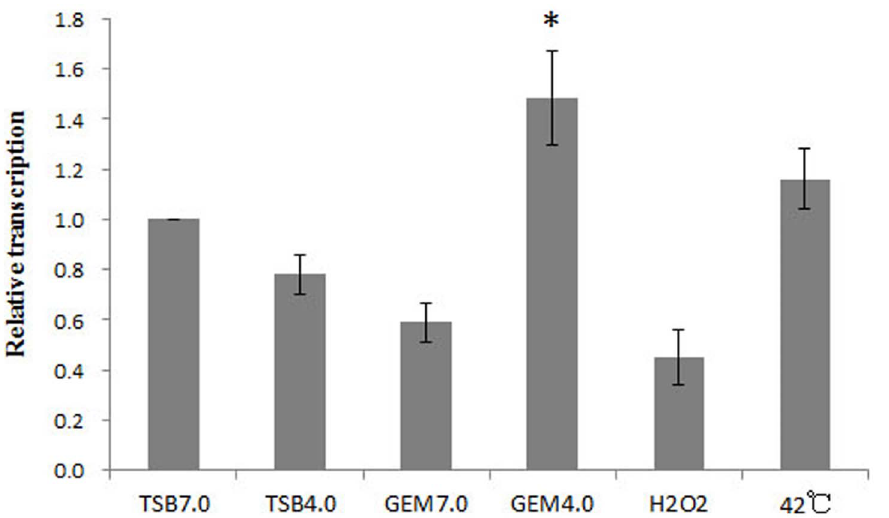
Figure 3. Determination of the in vitro induction conditions for hfq . 16 M was firstly cultured in TSB (pH7.0) to the stationary phase and then subjected to different stresses. RNA was isolated and transcription of hfq was quantified by qRT-PCR. Significant differences between the acidified minimum medium (GEM 4.0) and other in vitro stresses are indicated as follows: *, P , 0.05.